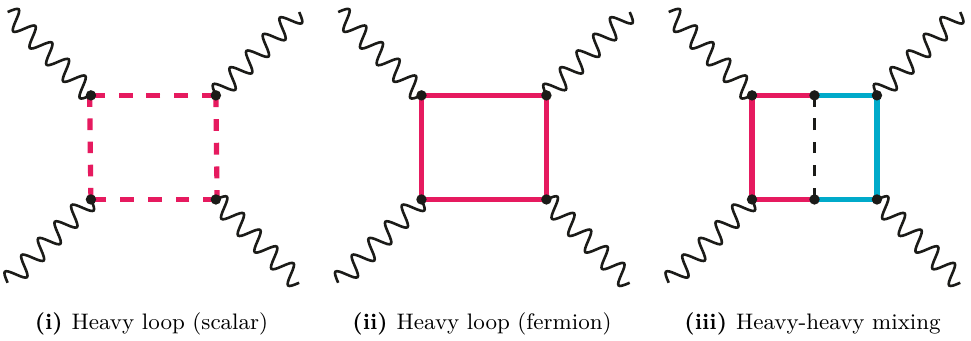
Figure 7. (i), (ii) One-loop and (iii) two-loop schematic diagrams revealing heavy field propagators enveloped within X 4 class of SMEFT